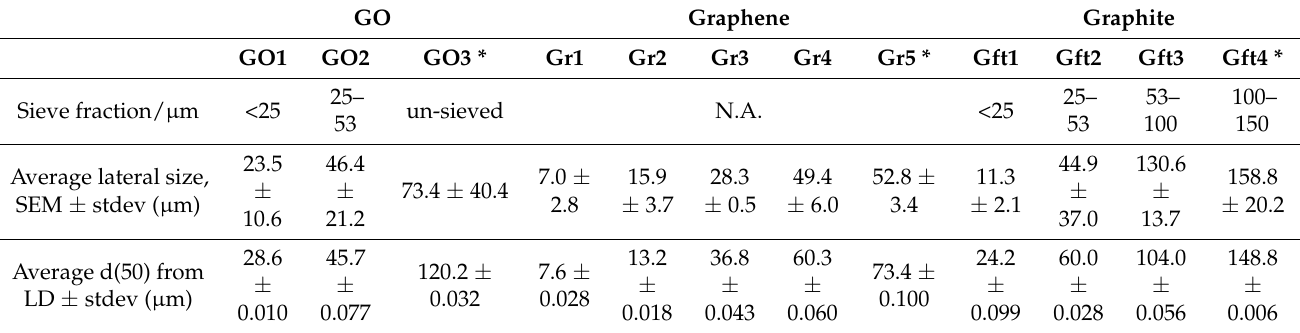
Table 1. Measurement results for comparative PSD/LD and SEM particle size characterization of the series of GO, graphene and graphite used in this study. Average lateral size measurements were performed following ISO/TS 21356-1:2021 [27] using in ate least 20–50 particles taken from SEM and TEM images at least 3 different spots. Results from PSD/LD measurements are presented as an average plus stdev are based on 3 LD